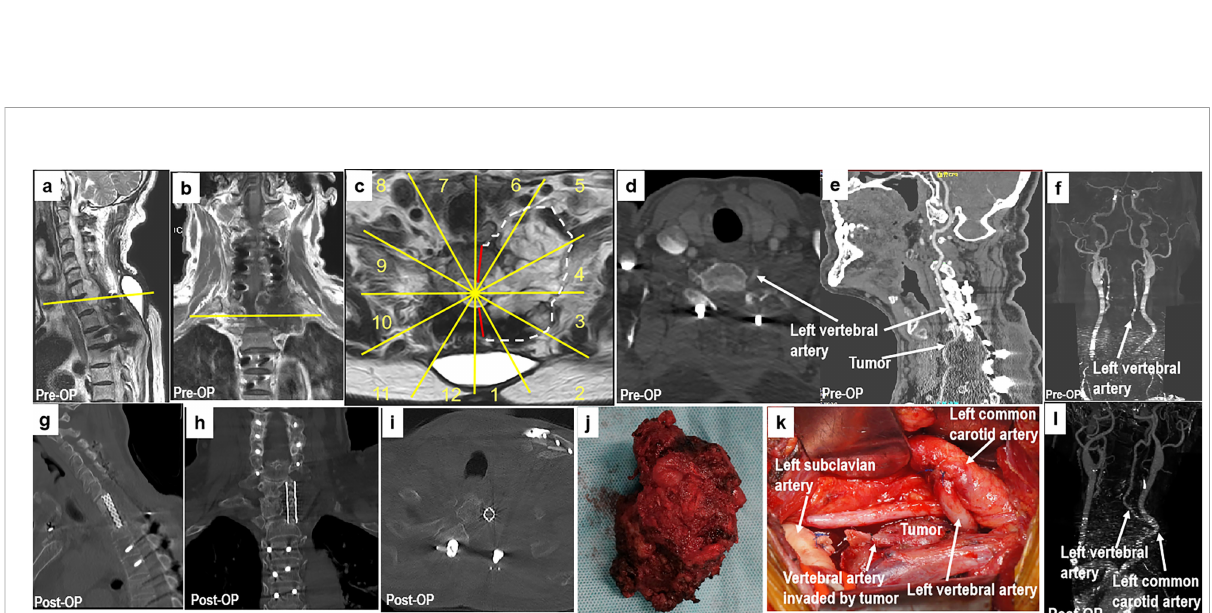
FIGURE 6 A 70-year-old man with chondrosarcoma at C7 – T1. The patient had undergone a piecemeal resection of a tumor in the paravertebral region of the cervicothoracic junction at another hospital. Ten months later, the patient experienced numbness in his upper left arm. MR images (A – C) show tumor recurrence along the left side of C7 to T1 paravertebral CT scans (D, E) , and CT angiography (F) shows that the left vertebral artery was invaded by the tumor (sectors 1 – 5, D, F , WBB). Based on the WBB classi fi cation of the tumor, sagittal en bloc resection was performed using the rotation – reversion technique with a combined approach. The left vertebral artery was cut off outside the tumor and anastomosed with the left common carotid artery (K) . Postoperative CT angiography showing fl uent blood fl ow in the left vertebral artery (L) . Postoperative CT scanning (G – I) and a photograph of the gross specimen (J) showing the margins of sagittal en bloc resection. WBB, Weinstein – Boriani –